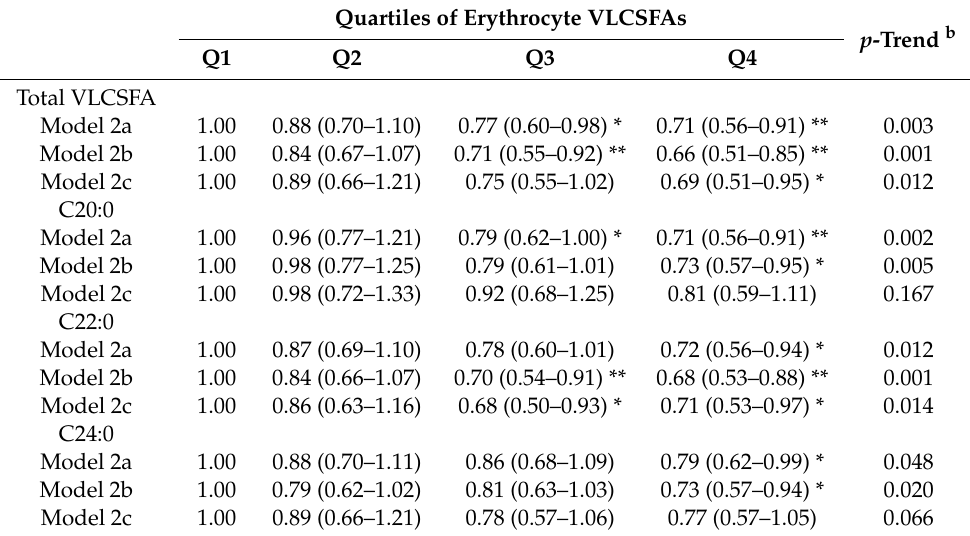
Table 2. Results of the sensitivity analysis for the associations between the erythrocyte VLCSFA proportions and incidence of carotid artery plaques in women a